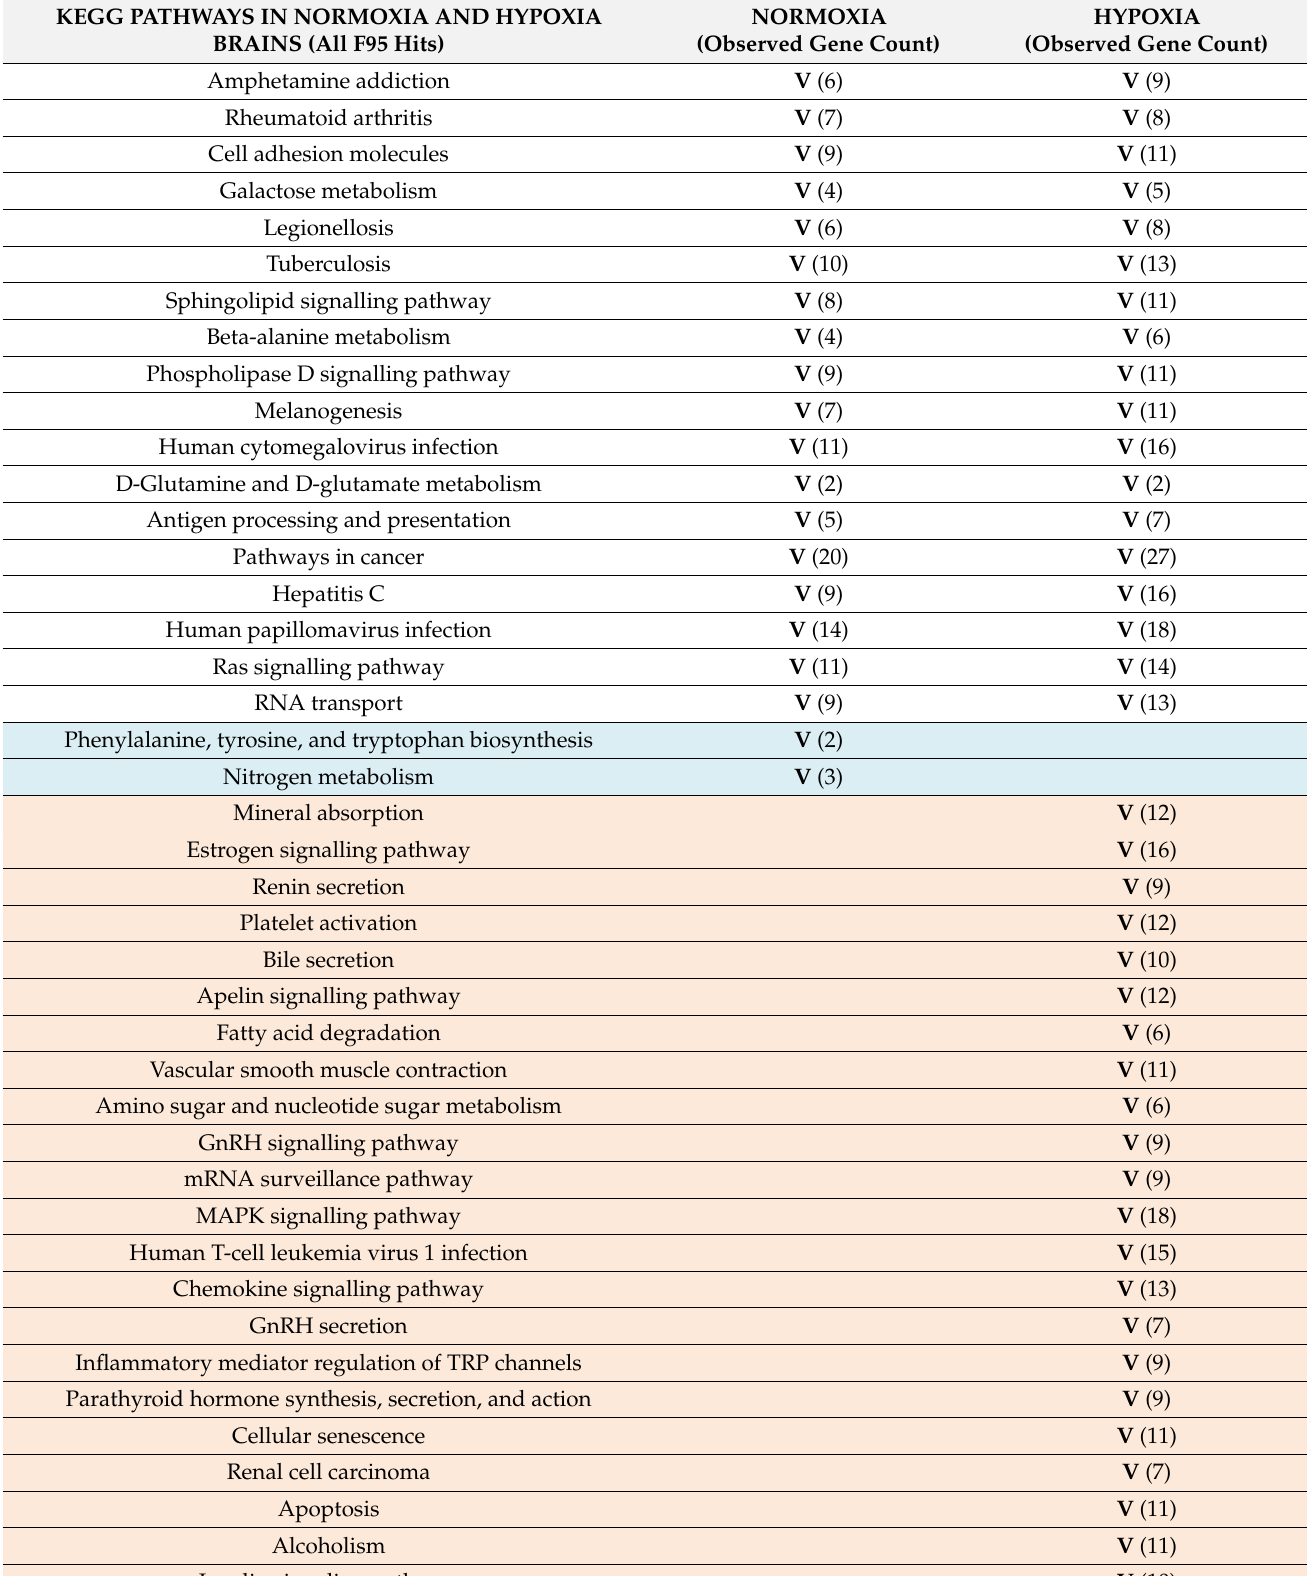
KEGG PATHWAYS IN NORMOXIA AND